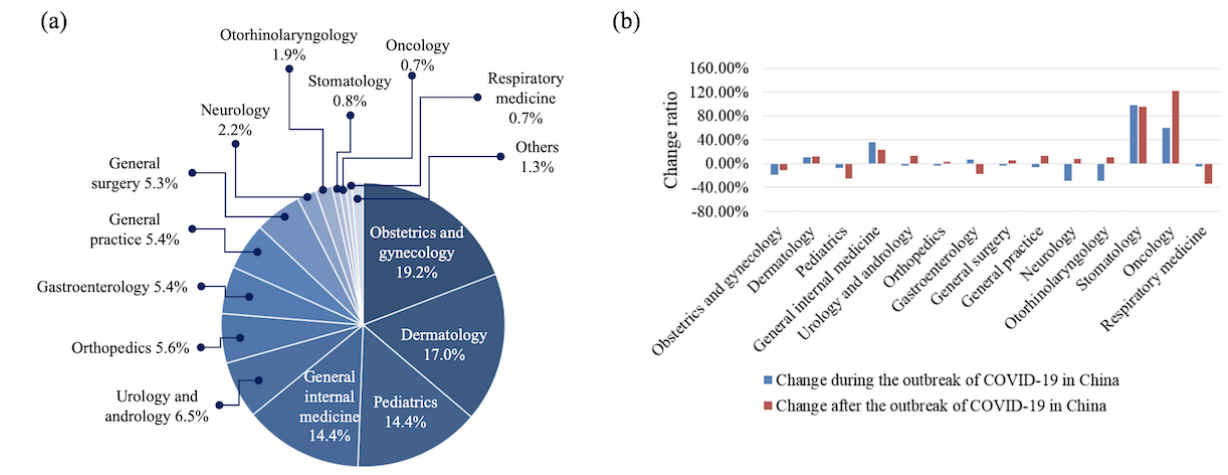
Figure 3. Departments represented in the consultations and inquisitions: (a) distribution of the departments; (b) change ratios of the distribution of the top 14 departments during and after the outbreak of COVID-19 in China.